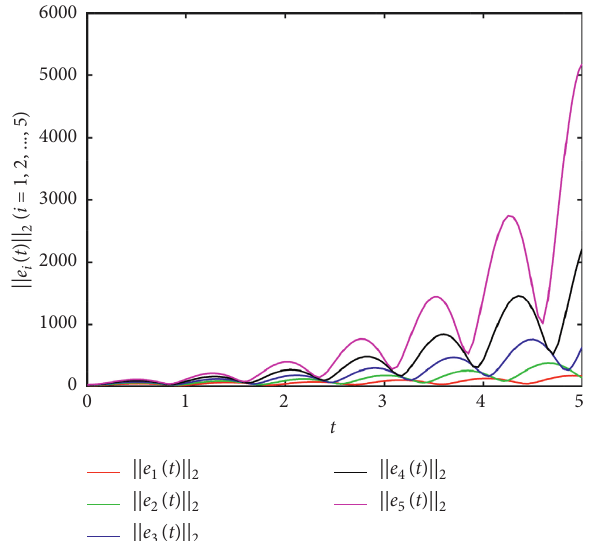
Figure 1: The changes of ‖ e